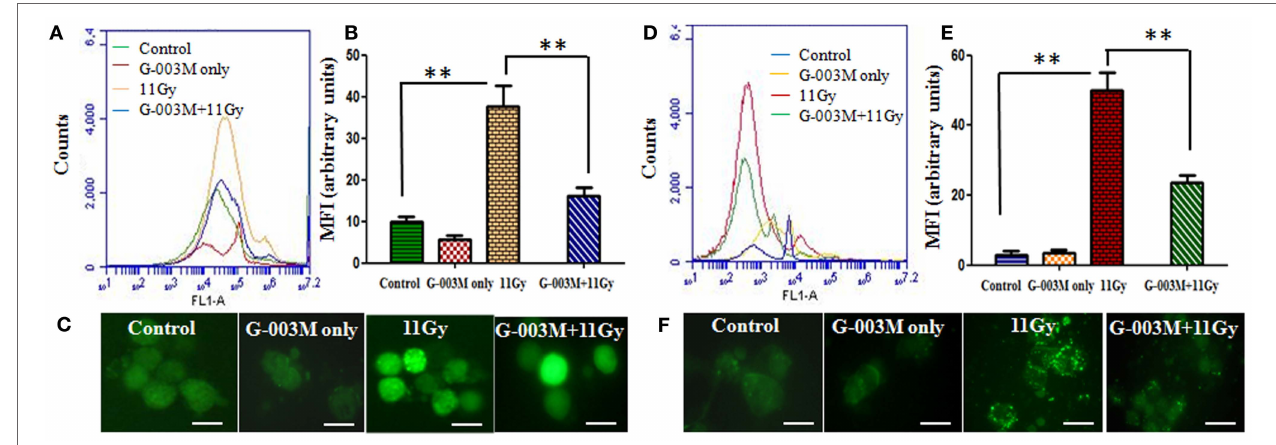
FigUre 2 | Effect of G-003M on reactive oxygen species (ROS)/nitric oxide (NO) formation in bronchoalveolar lavage cells of 11 Gy thoracic-irradiated mice. (a) Histogram representing changes in ROS formation in bronchoalveolar lavage fluid (BALF) cells detected by ROS-sensitive fluorescent dye 2 ′ ,7 ′ -dichlorofluorescein diacetate, 1 h posttreatment. (B) Bar graph indicating the mean fluorescence intensity (MFI) detected at a 488 nm excitation and a 535 nm emission using flow cytometer. (c) Fluorescence microscopic images of radiation-induced ROS formation in BAL cells from the lungs of differentially treated mice. (D) Histogram representing NO generation in BALF cells at 1 h posttreatment. NO was detected by staining the cells with NO-sensitive fluorescent dye 4,5-diaminofluorescein diacetate. (e) Bar graph indicating the MFI. (F) Fluorescence microscopic images of NO generation in BAL cells. Images were viewed at 1,000 × under fluorescence microscope. Scale bar 10 µm. Data are represented as means ± SEM from six mice for each group. ** p <